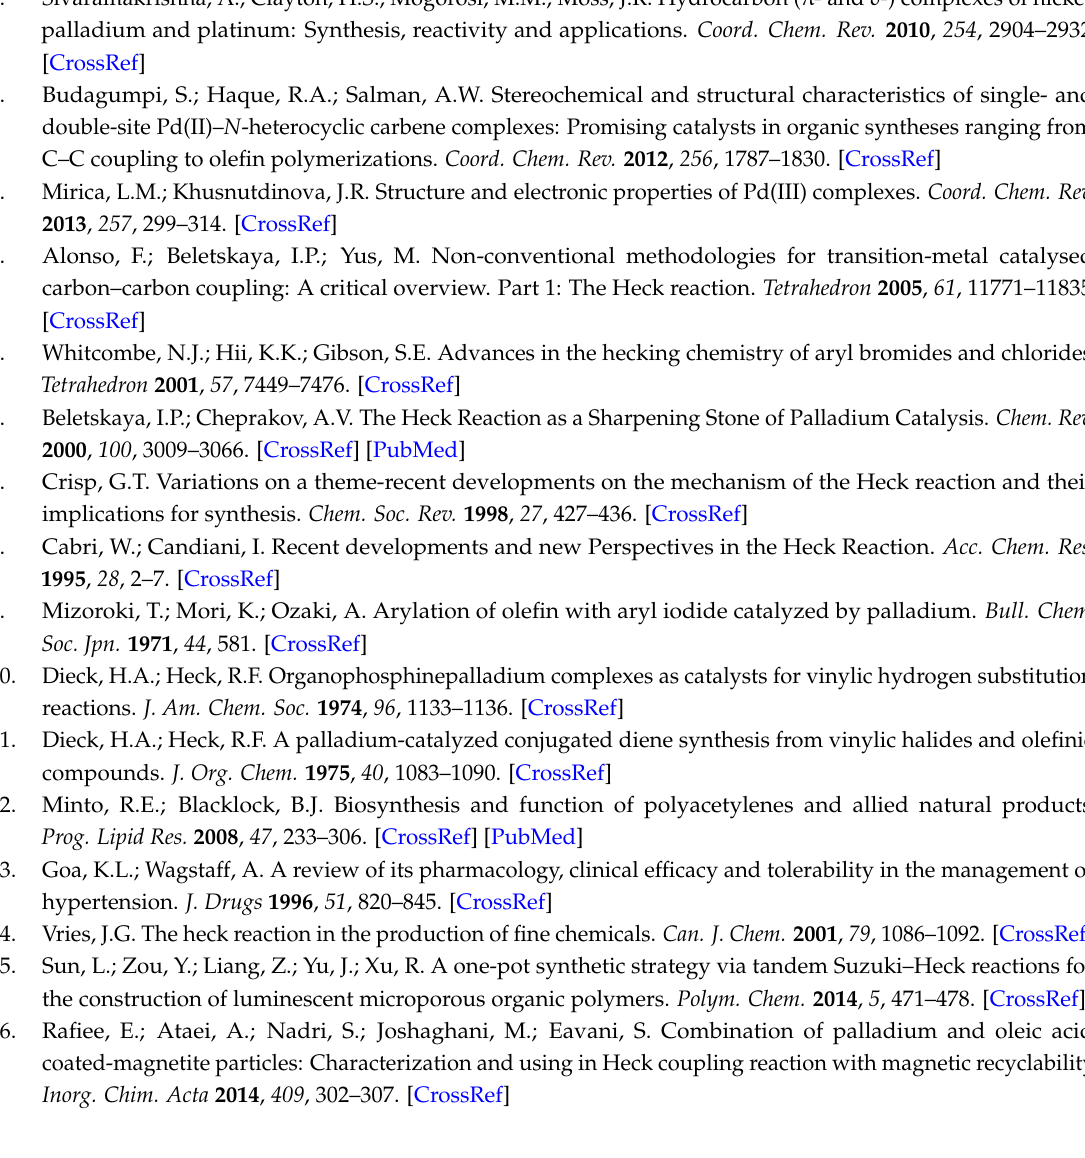
Table S2: Crystal data and structure refinement for complexes Pd4 and Pd5 . Supplementary materials can